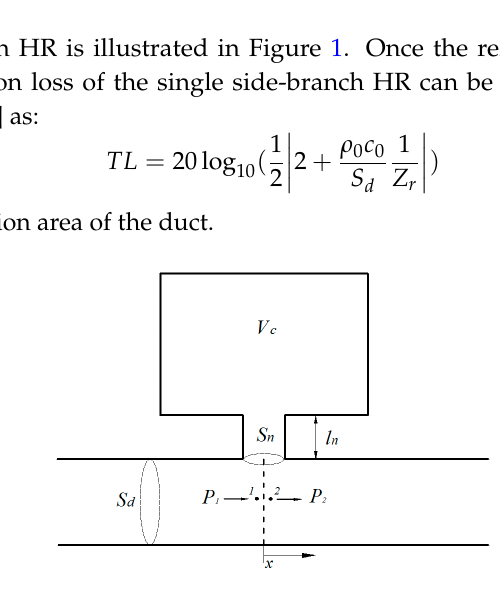
Figure 1. A single side-branch Helmholtz resonator.